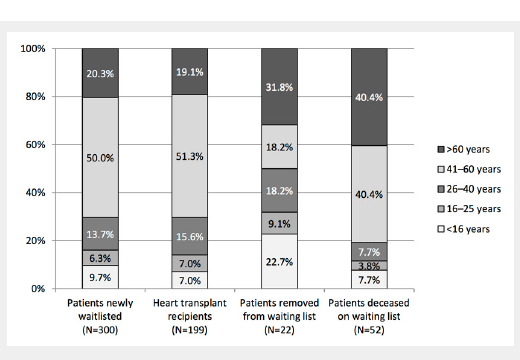
Heart offers: foreign vs Swiss procurement and non-transplanted vs